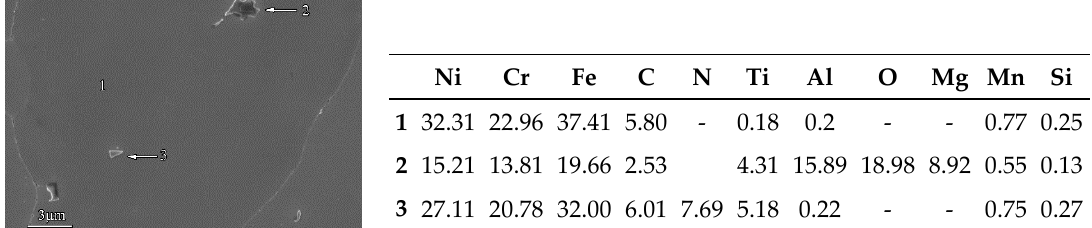
Figure 9. Compositions of precipitates in the GTAW welds of Alloy 52.